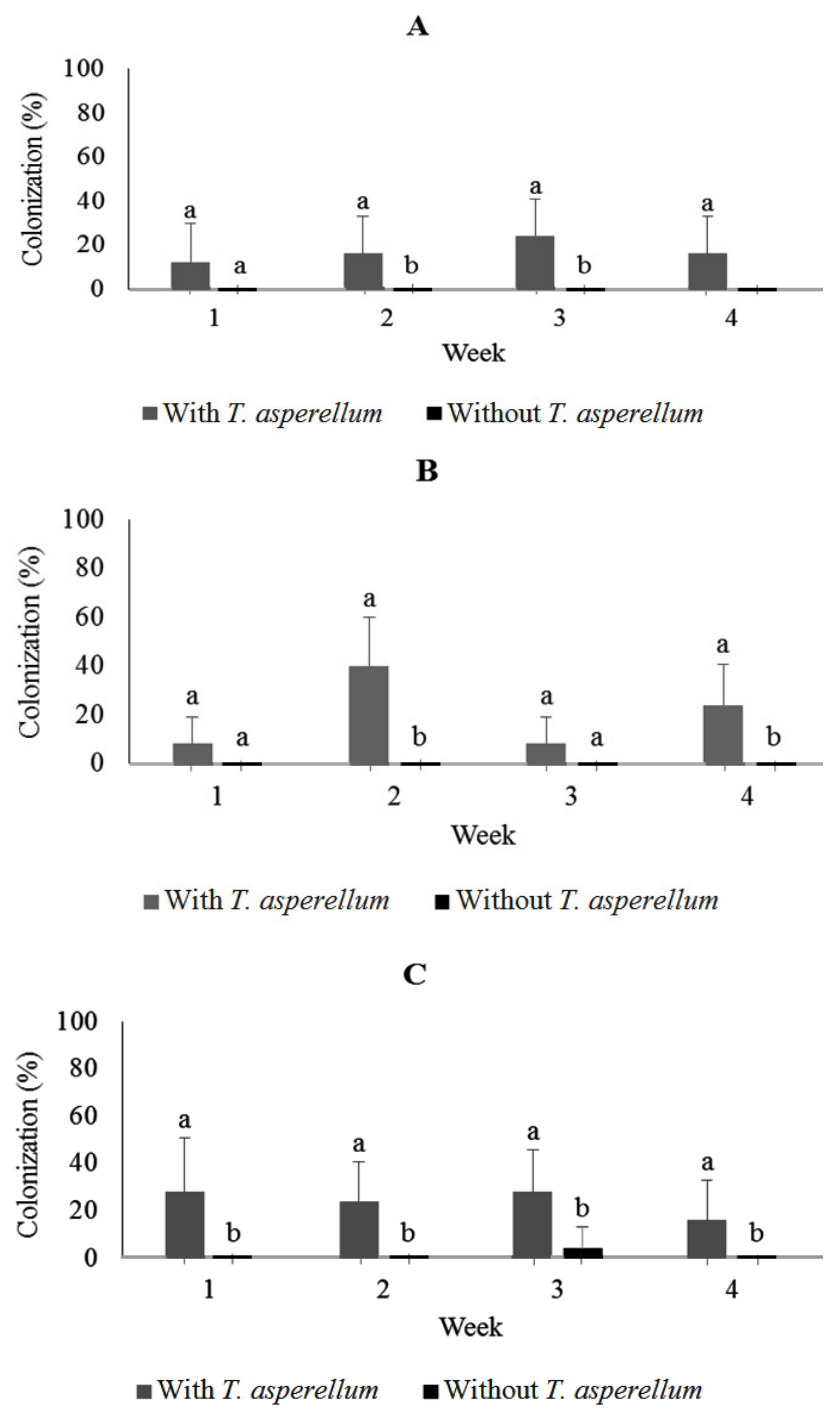
Fig. 3. Colonization of Trichoderma asperellum in leaf (A), stem (B) and root (C) tissues at one, two, three, and four weeks post-inoculation through soil drenching. Means of colonization at the same time followed by the same letter are not significantly different according to T-test